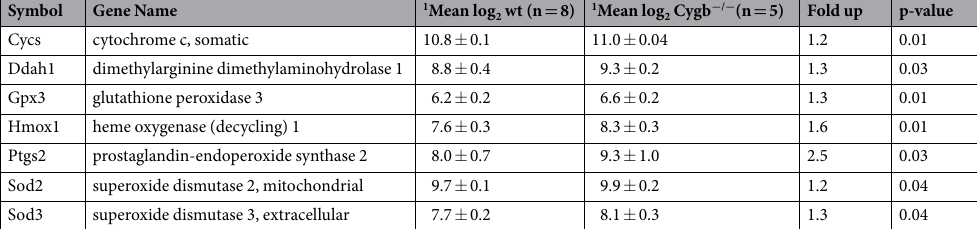
Table 1. Genes with differential expression during inflammation and encoding proteins involved in the metabolism of reactive oxygen species. 1 Mean log 2 expression measure ±